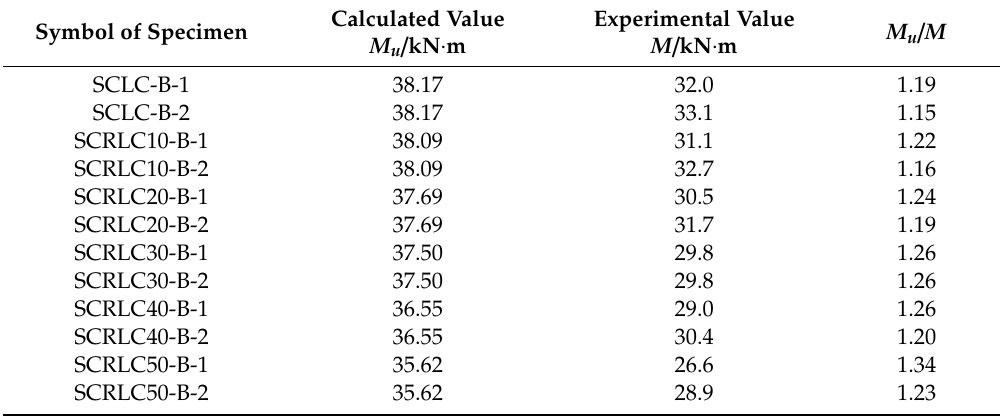
Table 10. Comparison between experimental and calculated values of the ultimate bending moment of composite